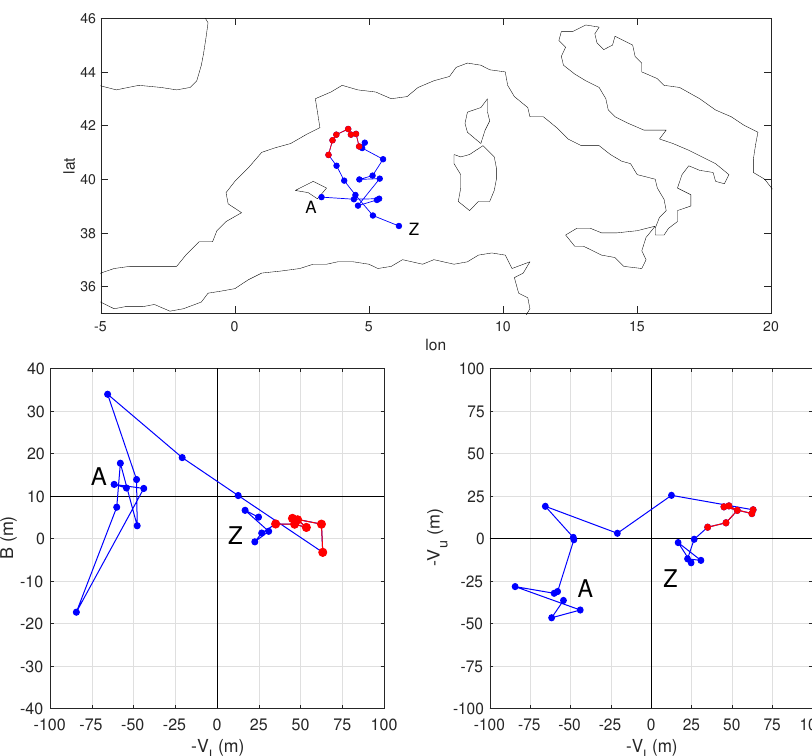
Figure 2. Example of a Hart analysis of a Medicane case that occurred on the 7 October 1996 in the convection permitting simulation, using a value of the pressure gradient threshold of 3.21 × 10 − 2 hPa km − 1 . The part in red refers to the stage in which the cyclone had a deep warm core and was symmetrical. The time step between dots is 3 h. The initial and final points along the trajectory are labeled respectively A (18:00 h on 5 October 1996) and Z (12:00 h on 8 October 1996). Note that these mark the first and last instants at which the Hart parameters could be computed: the trajectory actually was first (last) detected 3 h before (after) the point indicated as A